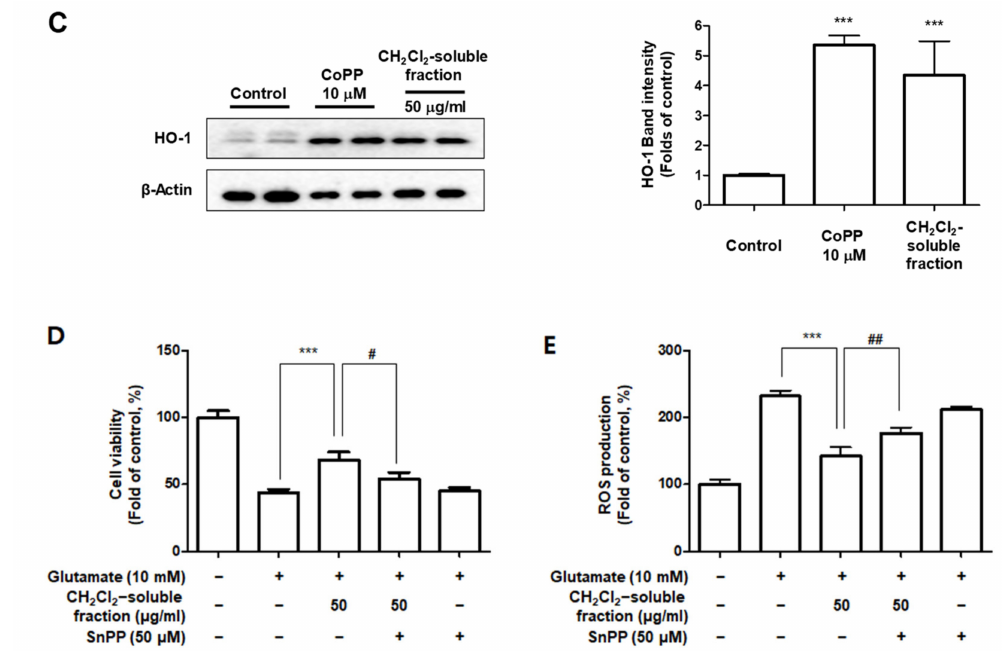
Figure 13. Effect of CH 2 Cl 2 -soluble fraction treatment on cell viability ( A ), ROS generation ( B ), and HO-1 expression ( C ) in HT22 cells, and effects of HO-1 induction by CH 2 Cl 2 -soluble fraction on glutamate-induced oxidative neurotoxicity ( D ) and ROS generation ( E ). ( A , B ) HT22 cells were treated with CH 2 Cl 2 -soluble fractions (12.5, 25, and 50 µ M) for 3 h and then incubated with glutamate (10 mM) for 12 h. ** p < 0.01, *** p < 0.001 compared to glutamate-treated cells. ( C ) Cells were incubated for 12 h with CH 2 Cl 2 -soluble fractions (50 µ g/mL) and analyzed using Western blotting. Band intensities were normalized to β -actin. CoPP (10 µ M) was used as a positive control. *** p < 0.001 when compared to the control group. ( D , E ) HT22 cells were treated with CH 2 Cl 2 -soluble fraction (50 µ g/mL) in the presence or absence of SnPP (50 µ M). ( D ) Cell viability and ( E ) ROS generation were measured following treatment with glutamate (10 mM) for 12 h. *** p < 0.001, # p < 0.05, and ## p < 0.01. All data are presented as the mean ± standard deviation for 3 independent